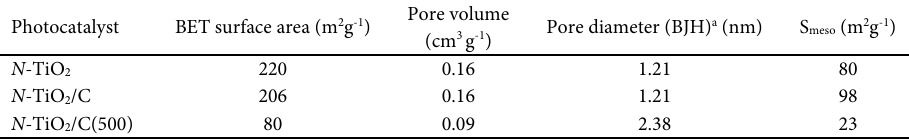
a Obtained from the adsorption branch of nitrogen isotherm by the BJH method